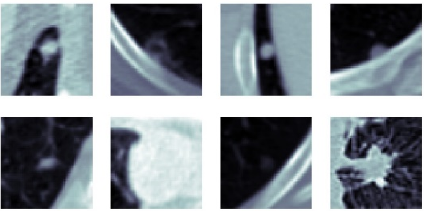
Figure 27. SFMPF model based on Gabor image—missed nodules (FN).